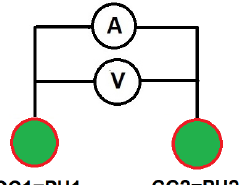
Figure 2. Schematic of a two electrode configuration set up, where both electrodes are used for current carrying (CC) and voltage pick up